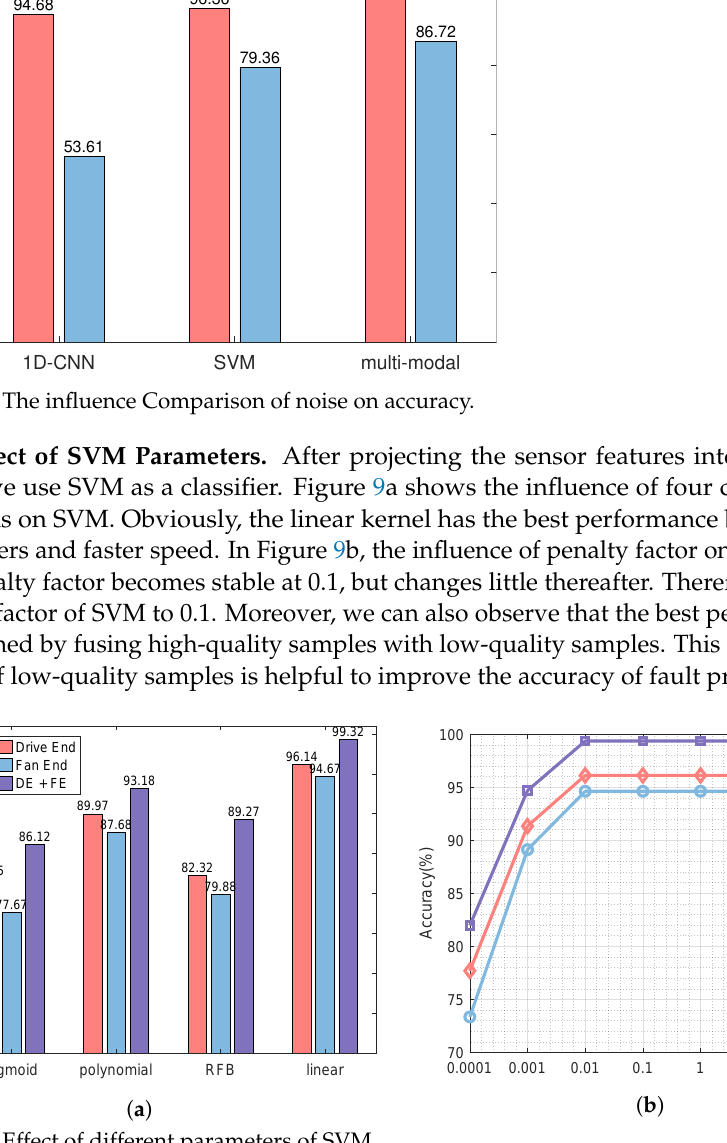
Figure 9. Effect of different parameters of